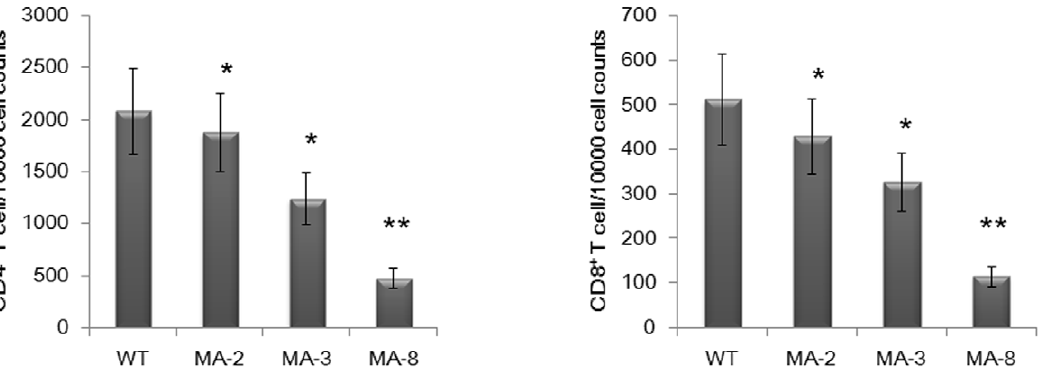
Figure 6. The frequency of peripheral blood CD4 + and CD8 + T lymphocytes. Peripheral blood samples were obtained from individual mice at 4 d.p.i and their PBMC were prepared. Subsequently, those PBMC were stained with fluorescent anti-CD4 or anti-CD8 and the frequency of CD4 + and CD8 + T cells were determined by flow cytometry analysis. Data are expressed as mean 6 SD of percentages of CD4 + or CD8 + T cells in each group of mice (n=10 per group) from three separate experiments. * P , 0.05 and ** P , 0.01 vs. the values in the mice infected with wild type virus.